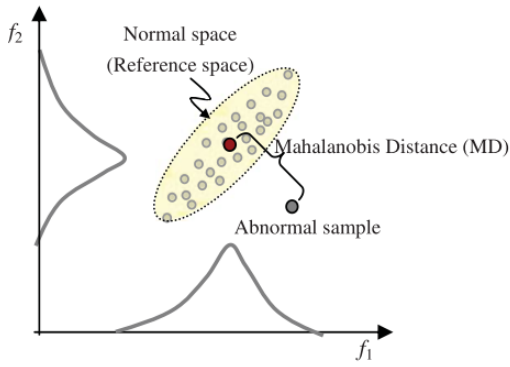
Figure 1. Example illustration of Mahalanobis Distance with two features.